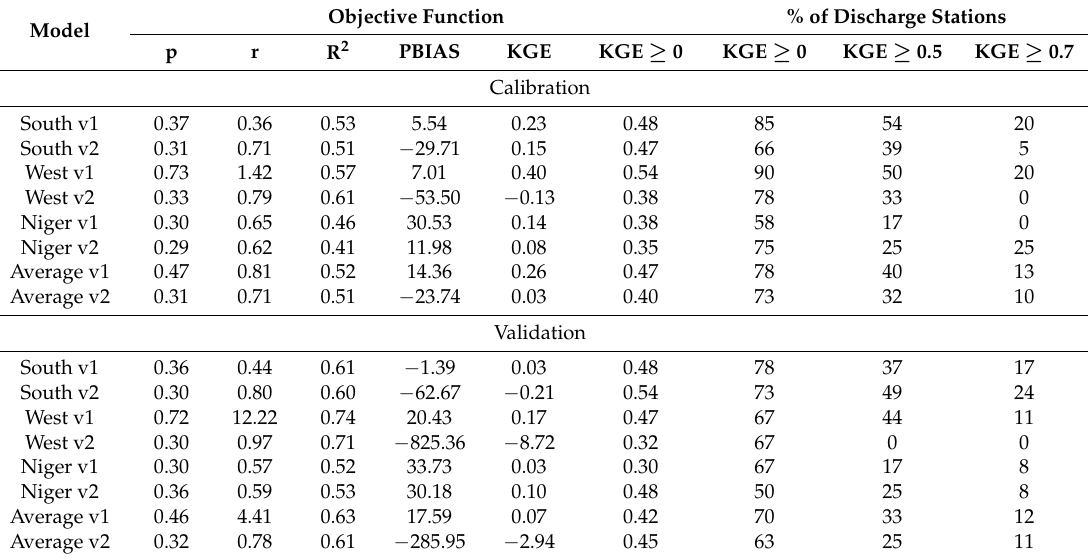
Table 3. Calibration and Validation Results for v1 and v2